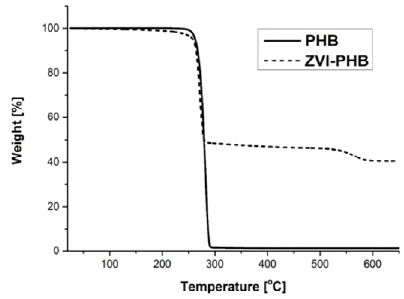
Figure 4. Thermogravimetric analysis (TGA) of thermally treated PHB and ZVI–PHB composite samples (ZVI/PHB ratio 1:2 w / w ).